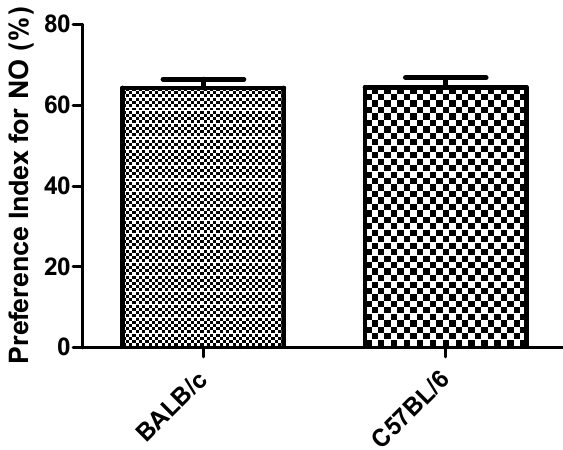
Figure 7. Response to the object recognition task in strains BALB/c and C57BL/6 mice by preference Index for NO-Novel Object. Data shows mean ± standard deviations for groups.